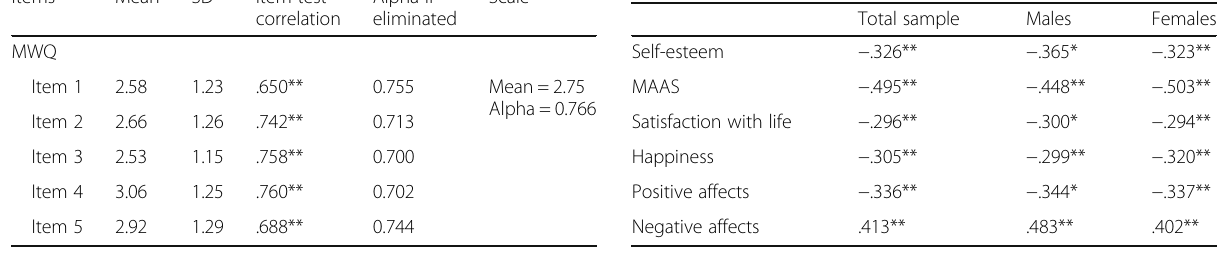
Table 3 Convergent